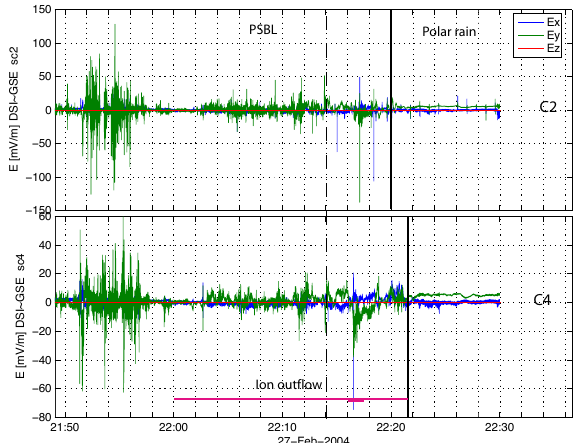
Fig. 9. Electric field components from the EFW instrument in the DSI coordinate system for C2 (top) and C4 (bottom). The PSBL and Polar rain regions are marked by vertical lines. For s/c C4, the time interval of ion outflow is indicated by the horizontal line and the time of maximum flux intensity by a thicker